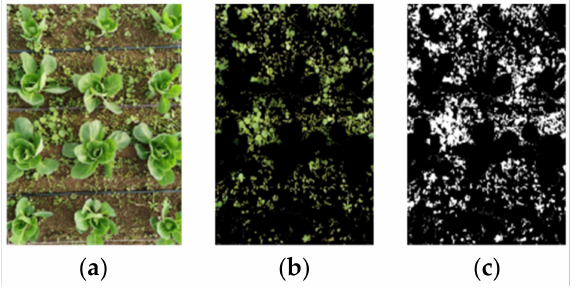
Figure 14. Diagram of the weed density calculation. ( a ) Original image; ( b ) Super green algorithm processing; ( c ) Binary weed image.